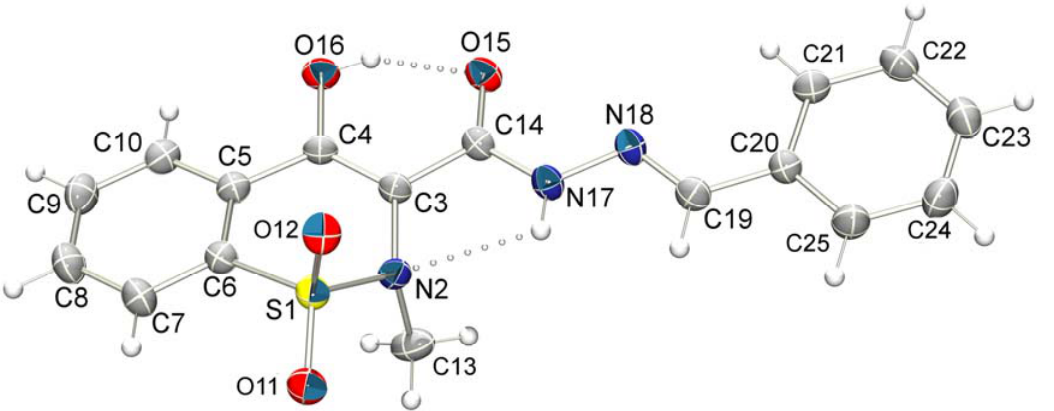
Figure 6. ORTEP view of compound 14a (LASSBio-1606) with atom displacement ellipsoids drawn at 30%